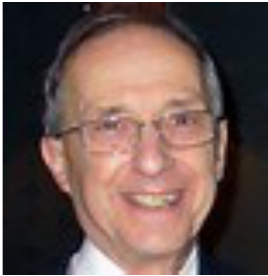
Figure 1. Sir Peter J. Lachmann—a quite rare photo of a laughing Peter.